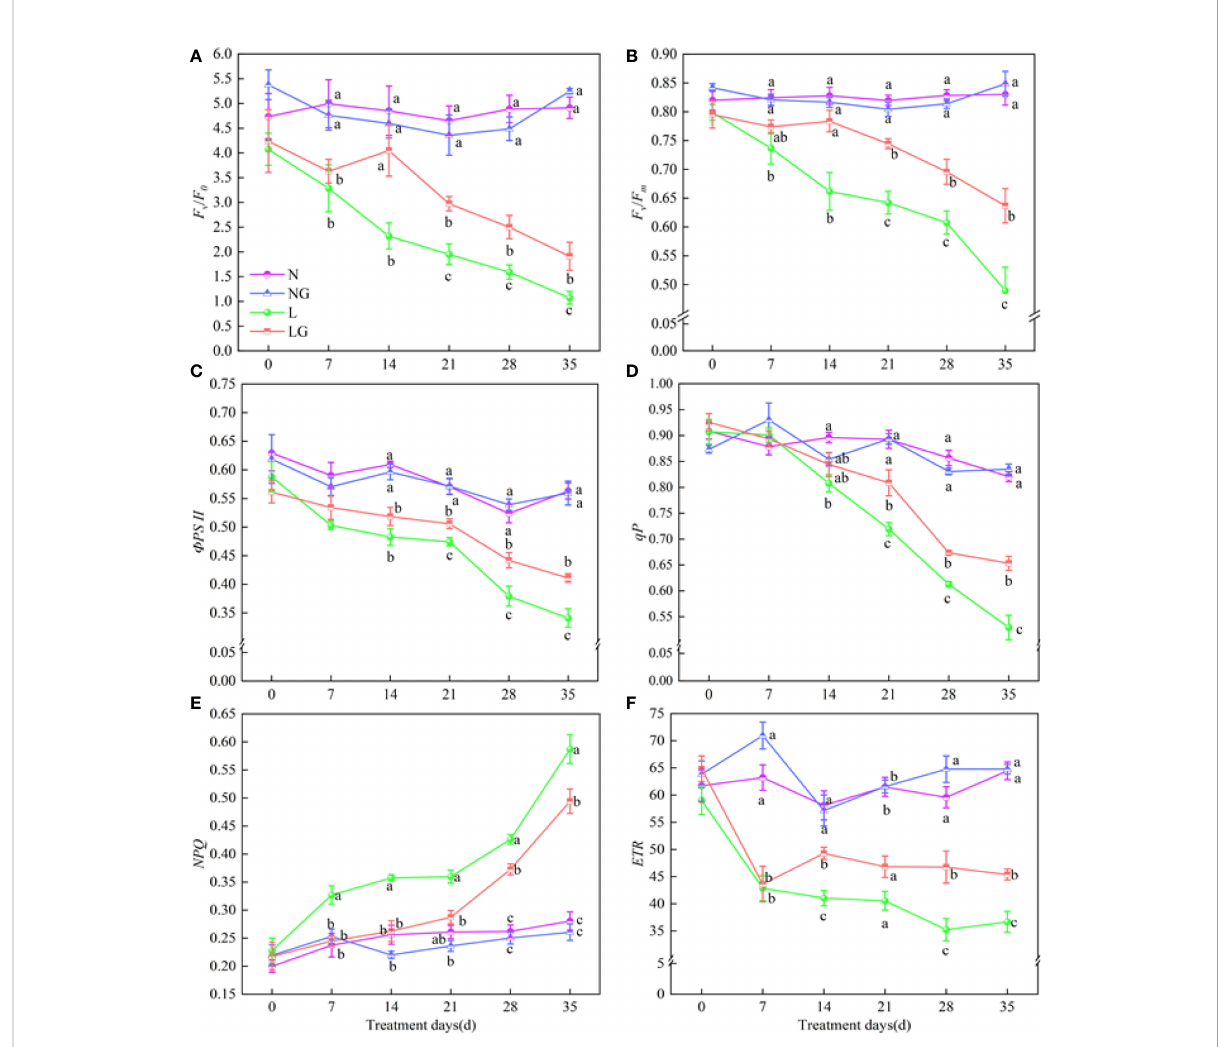
FIGURE 7 Effects of GABA spraying on the chlorophyll fl uorescence parameters of seedlings on different treatment days. (A) Potential photochemical ef fi ciency (Fv/F0) in leaves; (B) maximal photochemical ef fi ciency (Fv/Fm) in leaves; (C) photochemical quantum yield ( Ф PSII) in leaves; (D) photochemical quenching coef fi cient (qP) in leaves; (E) non-photochemical quenching coef fi cient (NPQ) in leaves; (F) photochemical electron transfer rate (ETR) in leaves. N, the plant pretreated with distilled water and grown at normal temperature. NG, the plant pretreated with GABA and grown at normal temperature. L, the plant pretreated with distilled water and grown at low temperature. LG, the plant pretreated with GABA and grown at low temperature. Different lowercase letters indicate signi fi cant differences between N, NG, L, and LG on the same treatment day ( P < 0.05). Those not marked with letters under the same treatment day indicate that there is no signi fi cant difference between